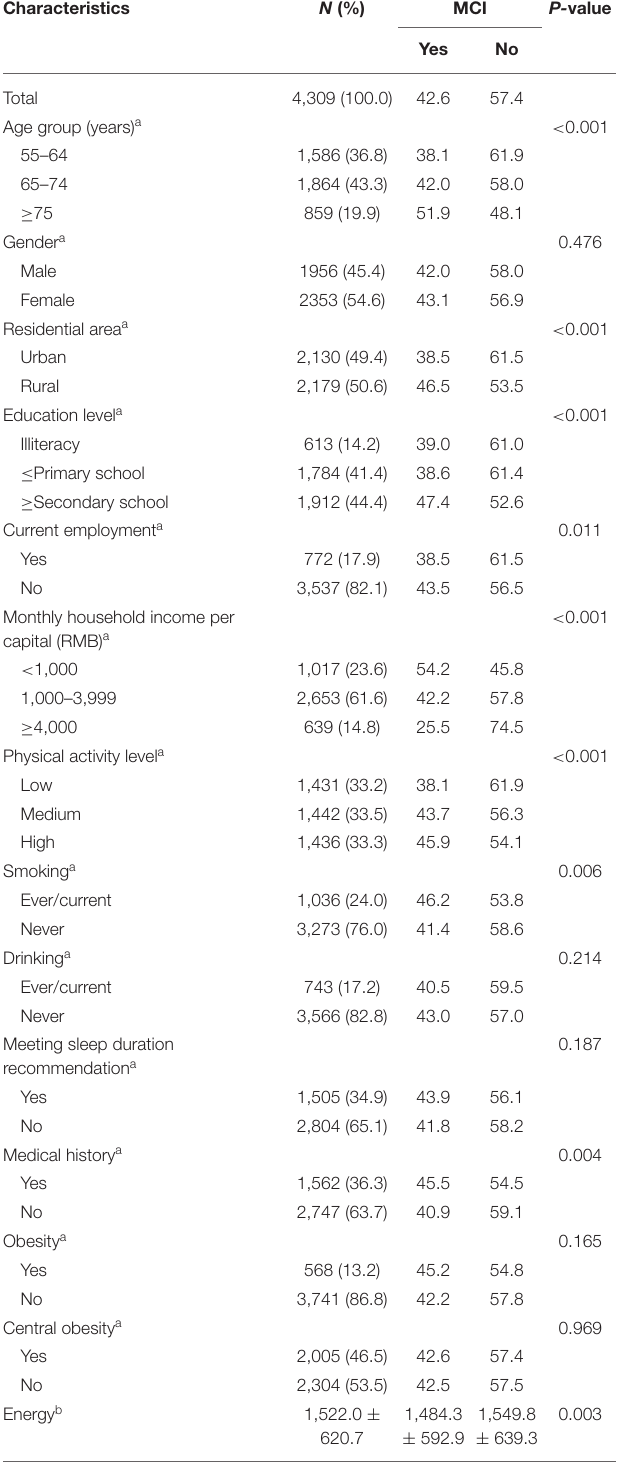
TABLE 1 | Subject characteristics by cognitive status among Chinese adults aged 55 years and above in the Community-based Cohort Study on Nervous System Diseases (CCSNSD)